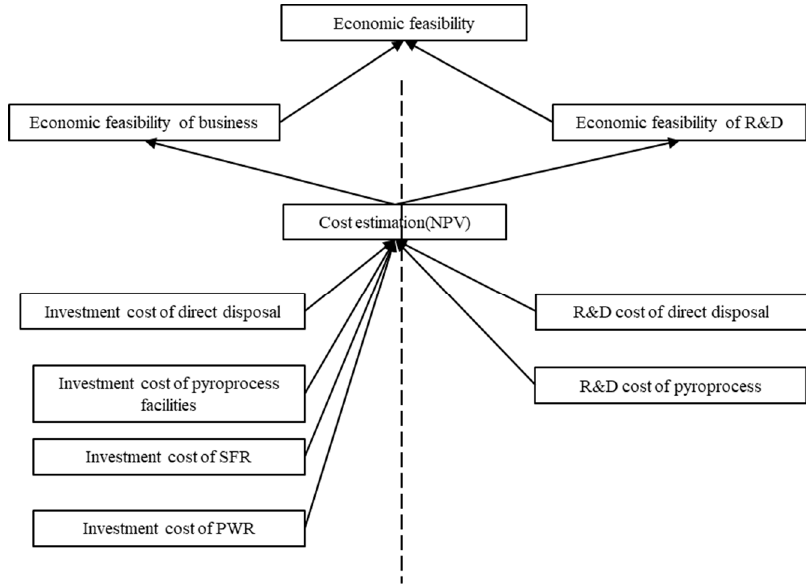
Figure 2. Economic feasibility analysis method with main cost drivers of business and R&D.